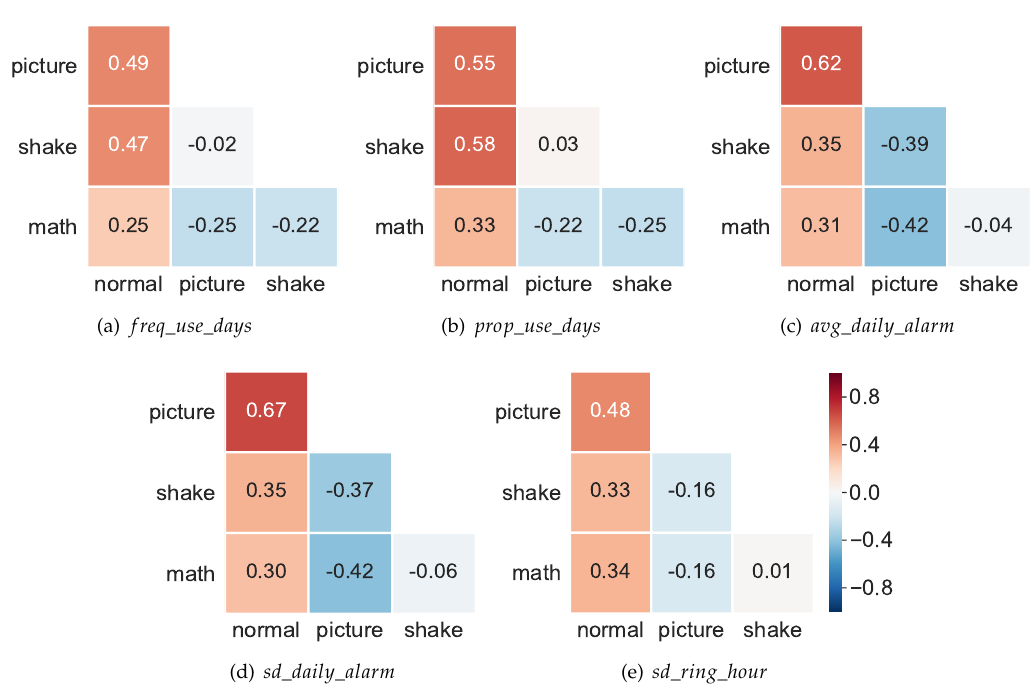
Figure 2. The magnitude of task-wise mean differences on alarm set-usage: Cohen’s d (col,